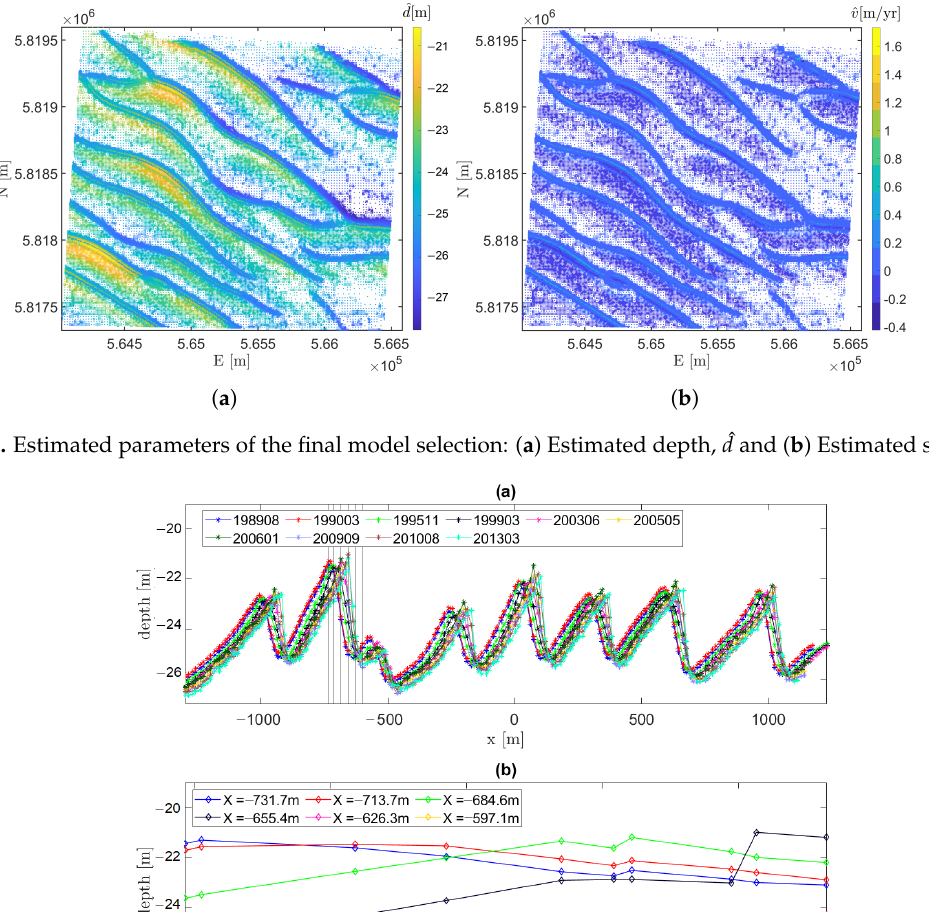
Figure 11. Model classification of the accepted, alternative models, M i ≥ 5 . ( a ) showing the epoch at which the offset was identified and ( b ) the size of the corresponding offset, ∆ ˆ d .